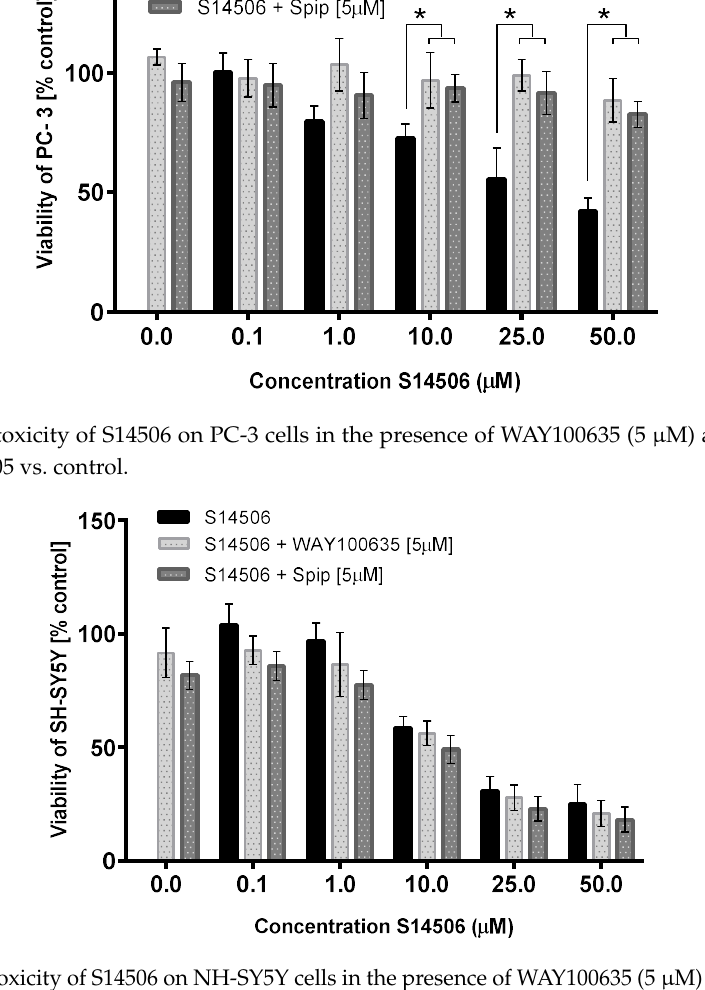
Figure 9. Cytotoxicity of S14506 on NH-SY5Y cells in the presence of WAY100635 (5 μM) and spiperone (5 μM).